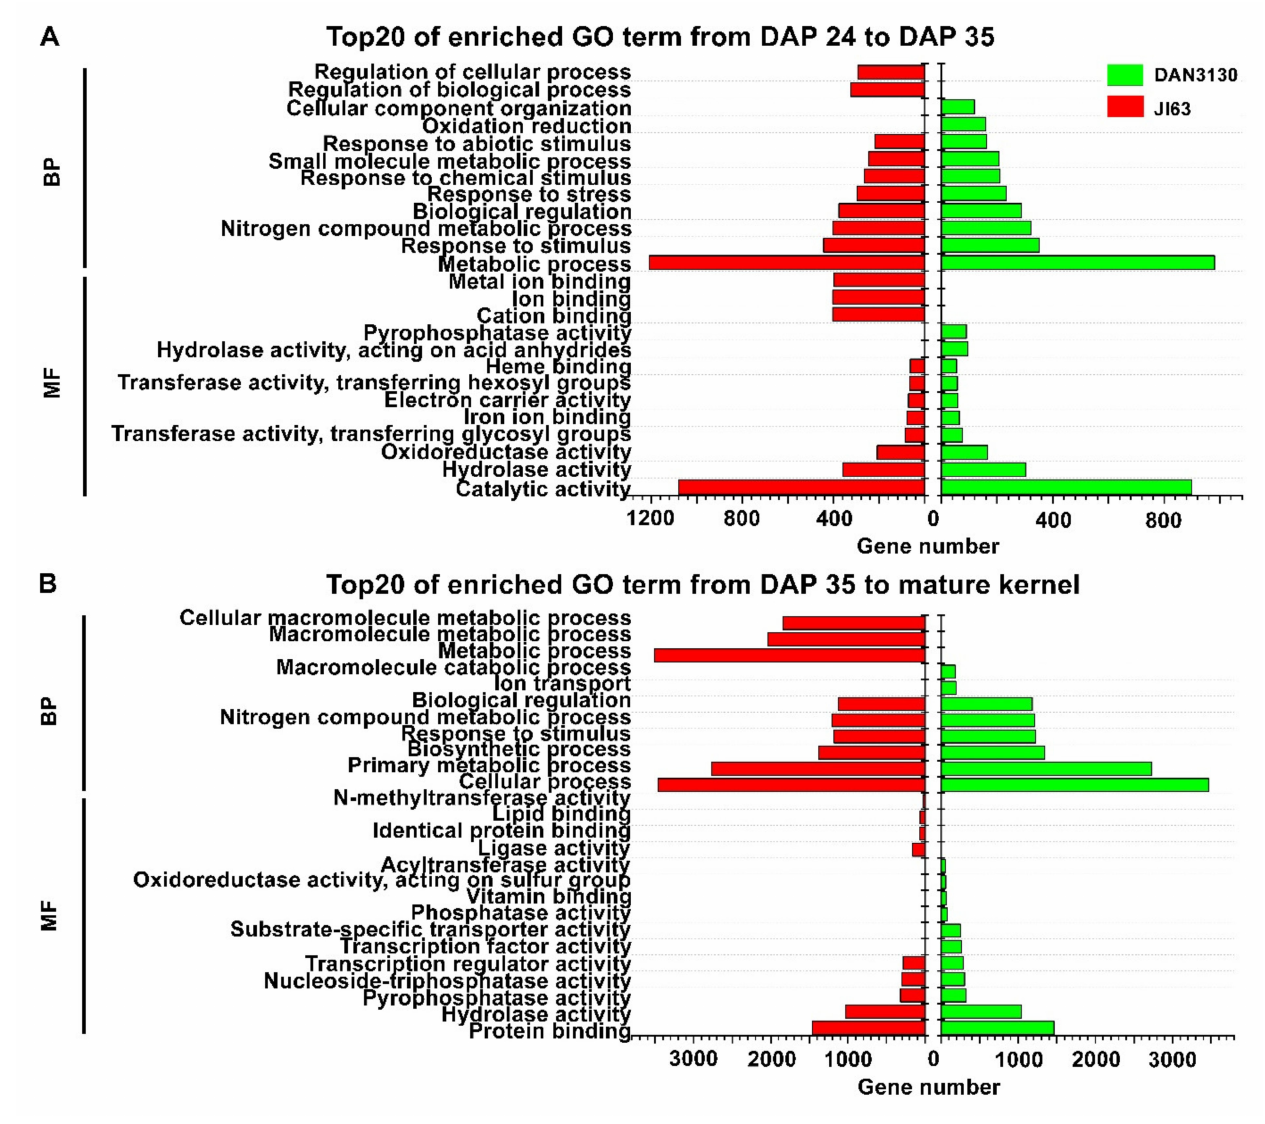
Figure 4. Bioinformatics analysis of DEGs in development-specific variation. ( A ) GO function analysis of DEGs during DAP 24 to DAP 35; ( B ) GO function analysis of DEGs during DAP 35 to mature kernel. MF, molecular function; BP, biological